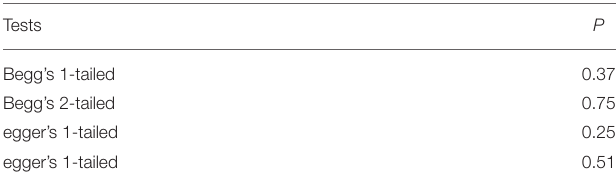
TABLE 5 | Begg’s and Egger’s tests to assess the publication